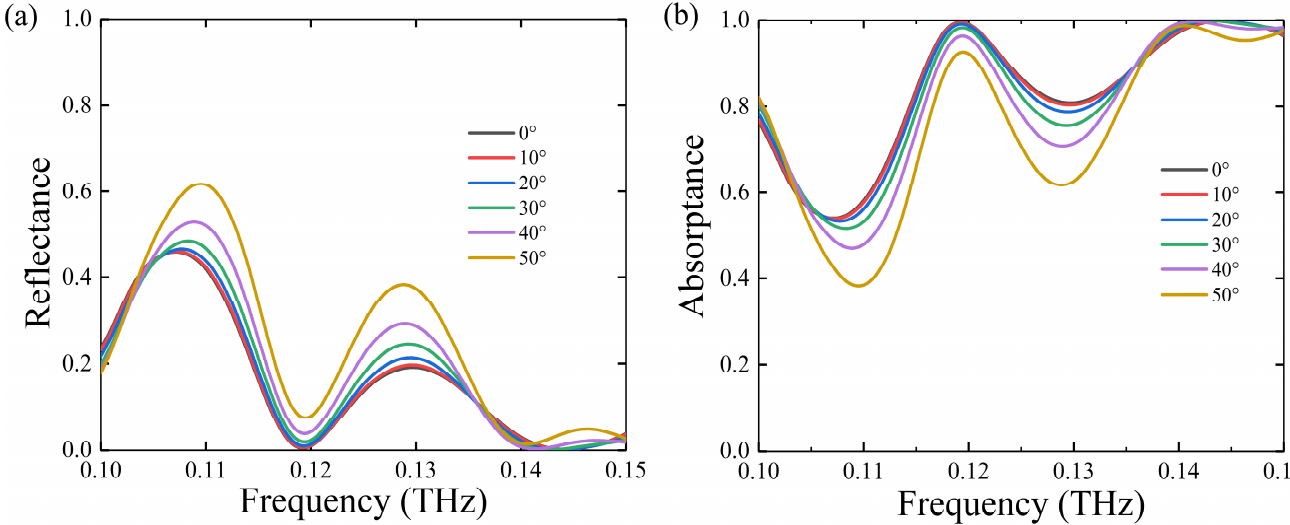
Figure 8. ( a ) The simulated reflectance spectrum and ( b ) absorptance spectrum for U at the frequency ranging from 0.1 to 0.15 THz when the incidence angle changes from 0° to 50°. The temperature is T = 300 K.